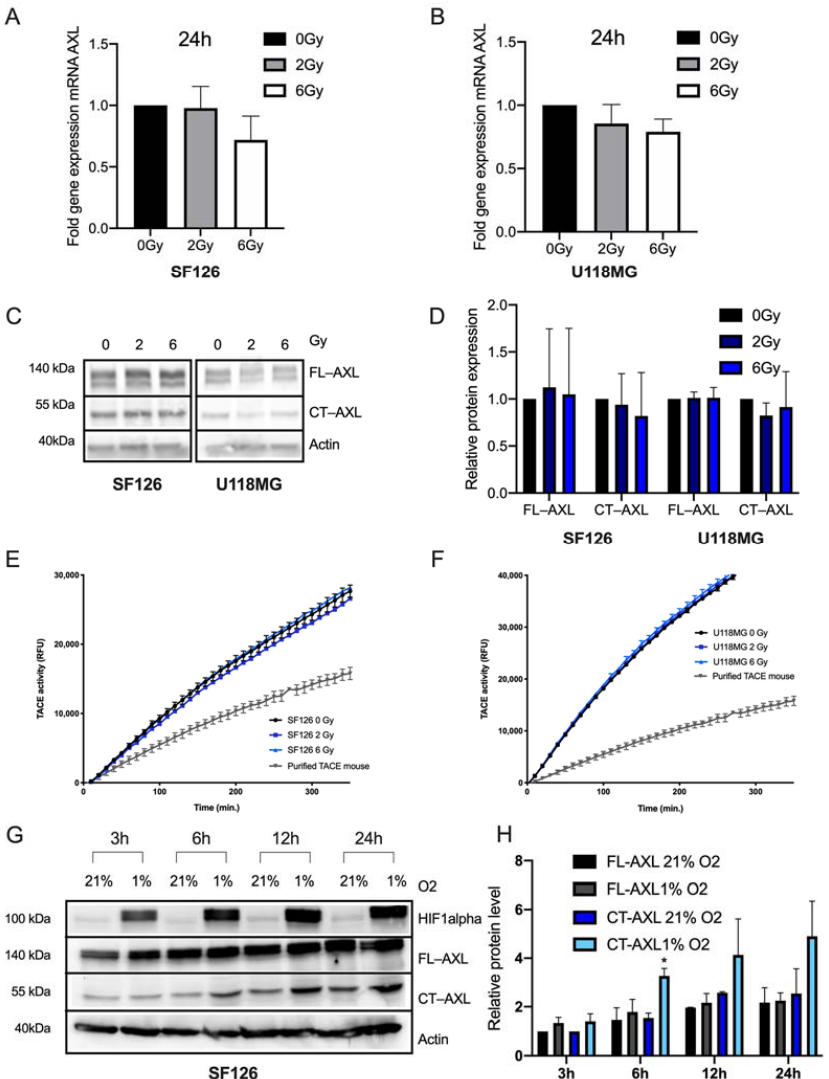
Figure 2. RTK-AXL undergoes post-translational modifications in a radio-resistant